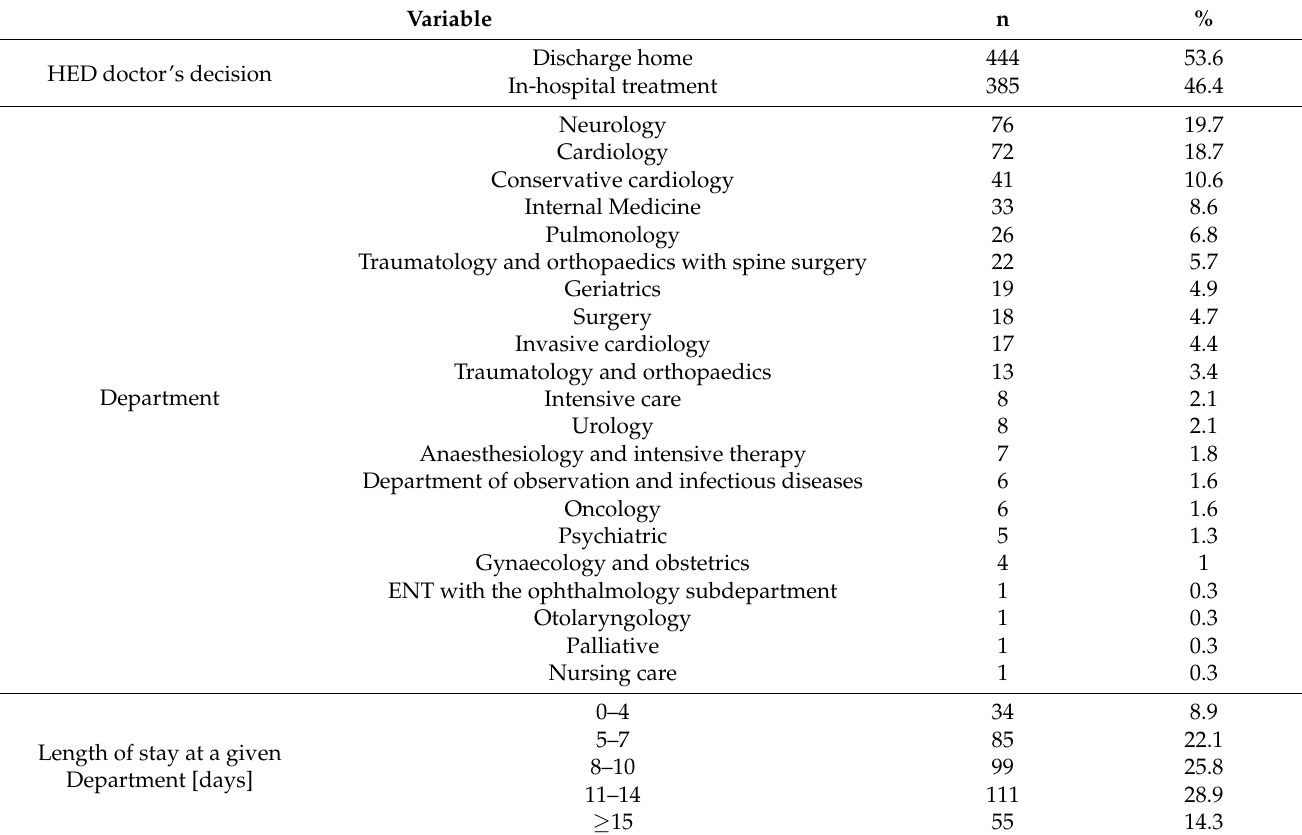
Table 9. In-patient treatment of patients admitted to different